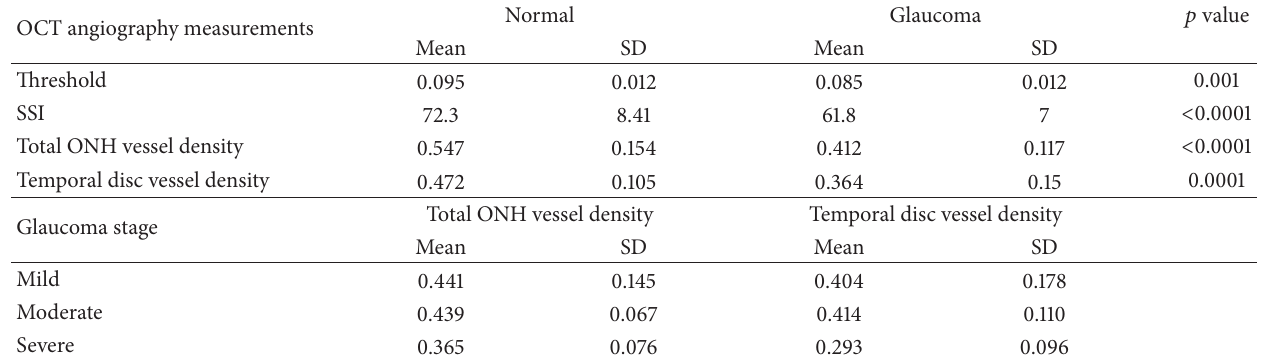
Table 3: OCT angiography measurements. SSI: strength signal index.